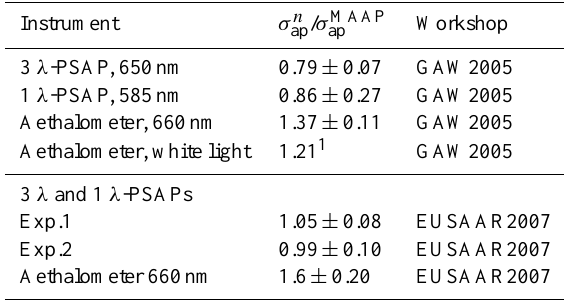
Table 10. Relative sensitivities of Aethalometer and PSAP com- pared to MAAP for ambient aerosol. Absorption coefficients were adjusted to 637nm using average ˚Angstr¨om exponents. The uncer- tainty is calculated from the unit to unit variability of the instru- ments. Correction methods are Bond (Bond et al., 1999) for PSAPs and Weingartner (Weingartner et al., 2003) for